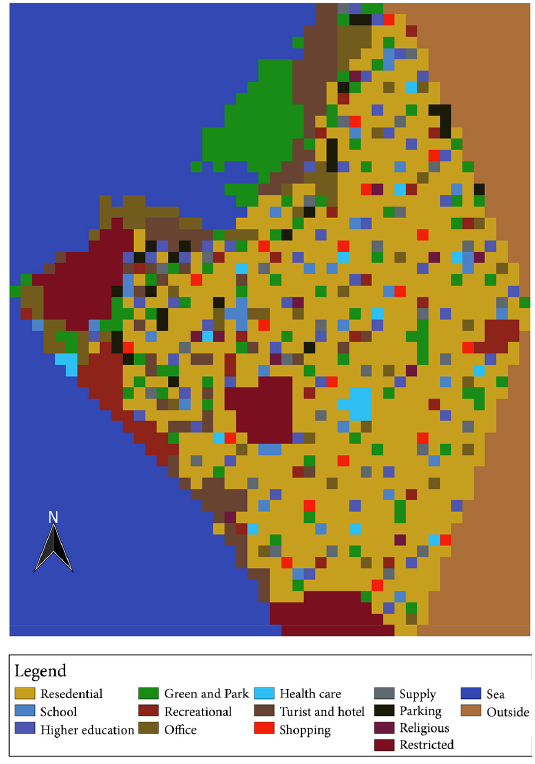
Figure 11. A land-use map from Zanzibar city (case study area), when the objective function of minimizing travel distance is prioritized (selecting point 1 from Figure